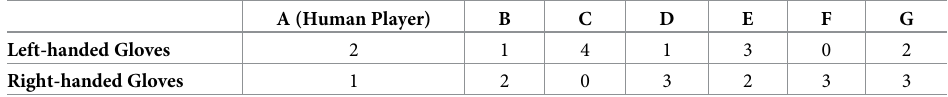
Table 1. Allocation of gloves to the seven players in the game with a single core